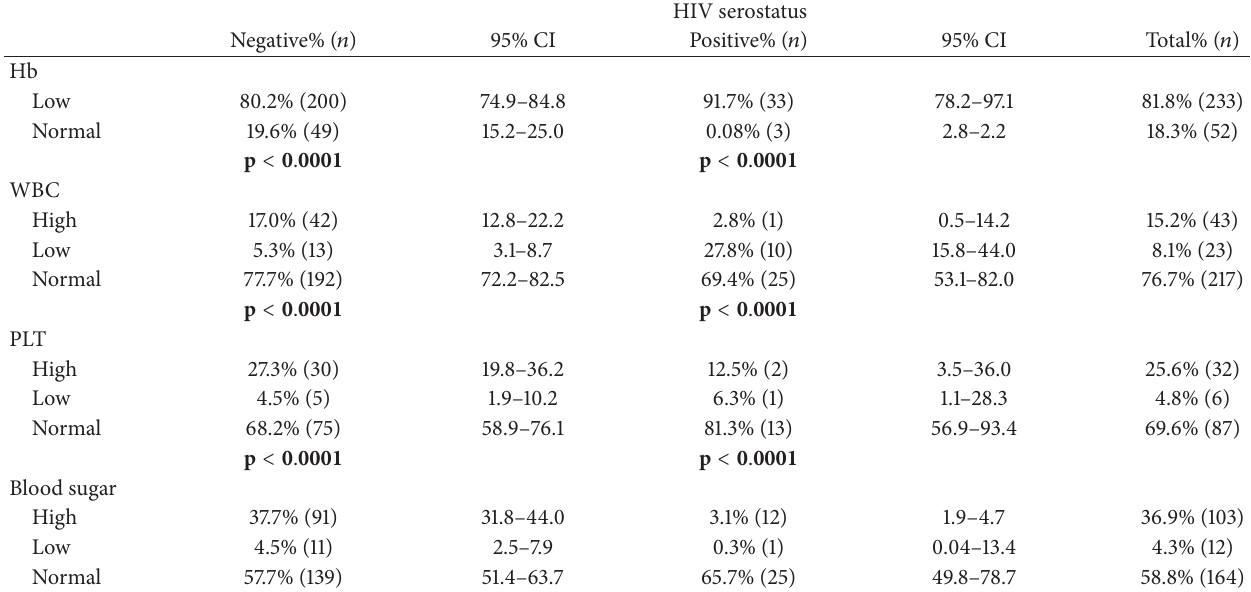
Table 2: Hematological parameters among TB and TB-HIV